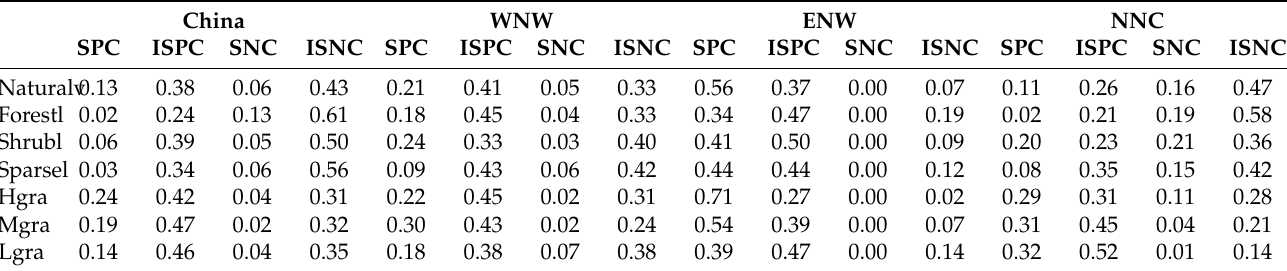
Abbreviations: Agrl—Agricultural land; Watr—Water bodies; Uril—Urban and rural land; Bald—Unutilized land; Forestl—Forest land; Shrubl—Shrubland; Sparsel—Sparse forest land; Hgra—High coverage grassland; Mgra—Medium coverage grassland; Lgra—Low coverage grassland; Snga—Permanent snow and glacier; WNW—Western arid and semi-arid region; ENW—Eastern arid and semi-arid region; TP—Qinghai-Tibet alpine region; NNC—Northern North China; SNC—Southern North China; WSC—Western South China; ESC—Eastern South